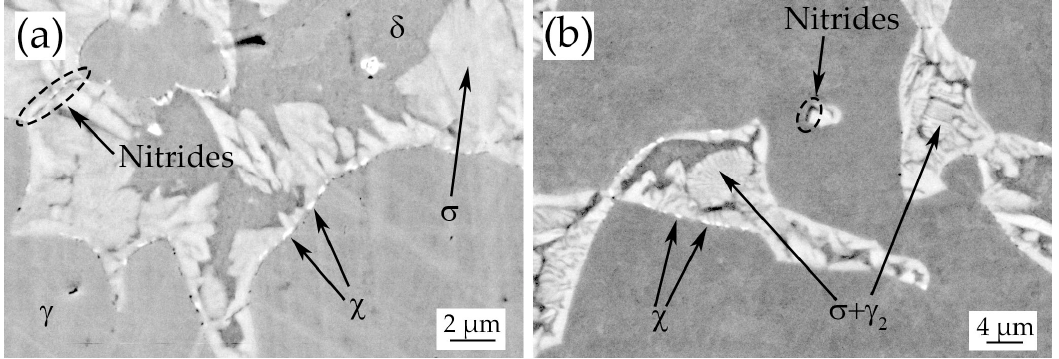
Figure 3. Microstructure after heat treatment at 900 °C 5 min ( a ), 950 °C 15 min ( b ).